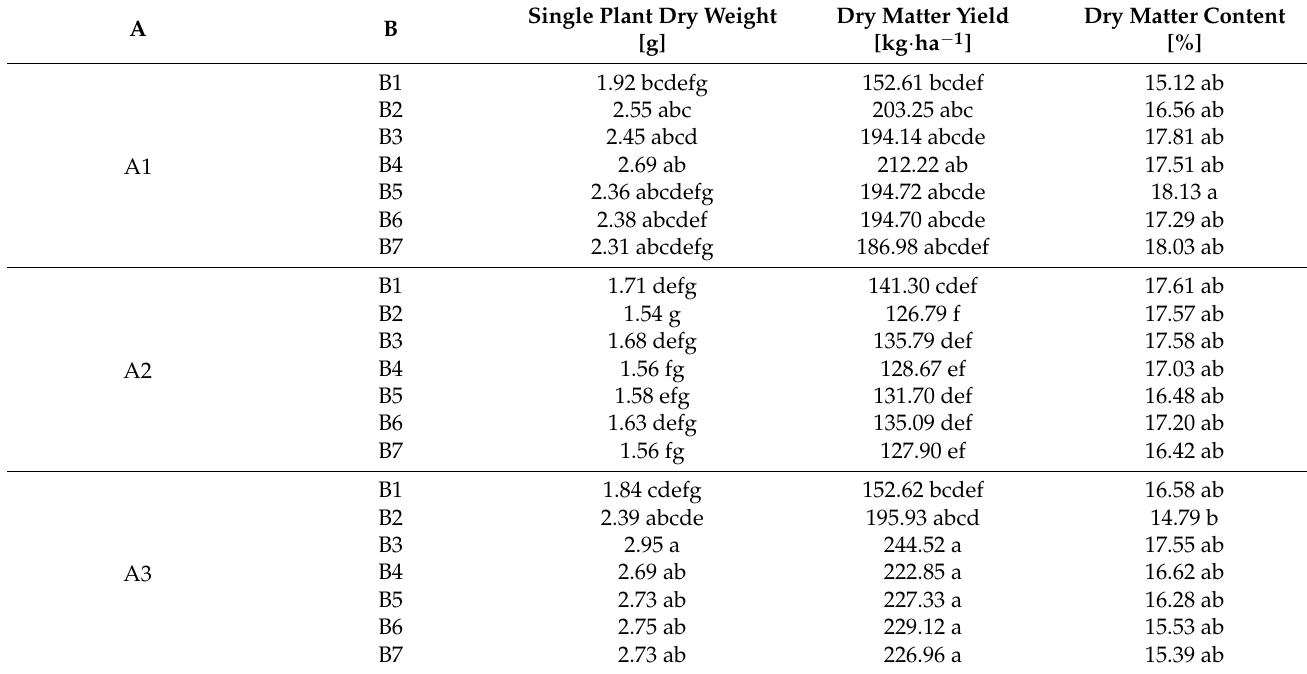
Table 7. Average values of the dynamics of dry matter accumulation for the combination of the cultivar (A) and fertilizer